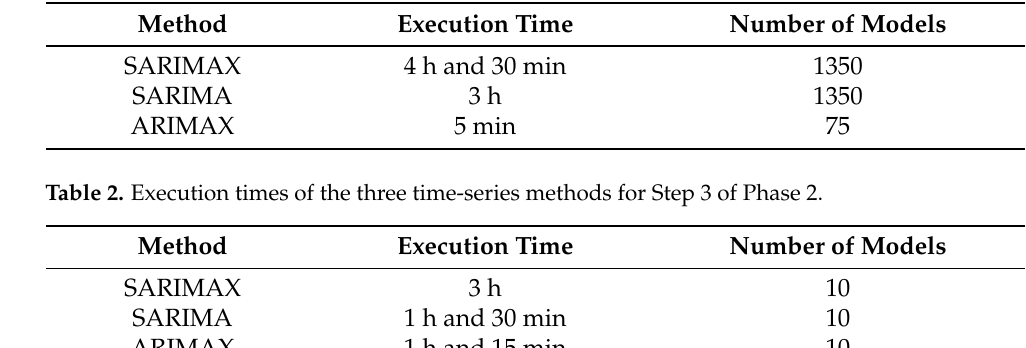
Table 1. Execution times of the three time-series methods for Step 2 of Phase 2.